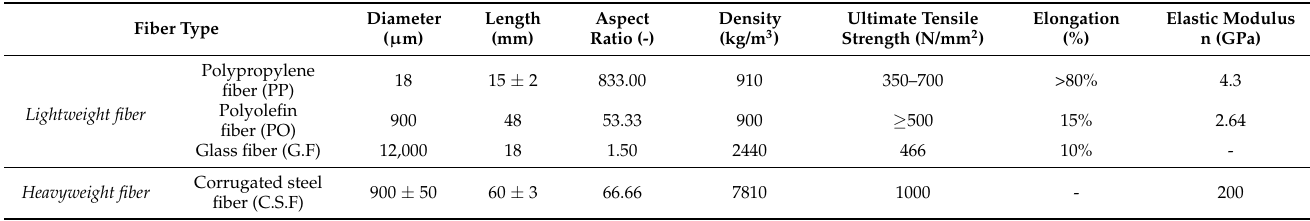
Table 2. Technical specification of fibers.